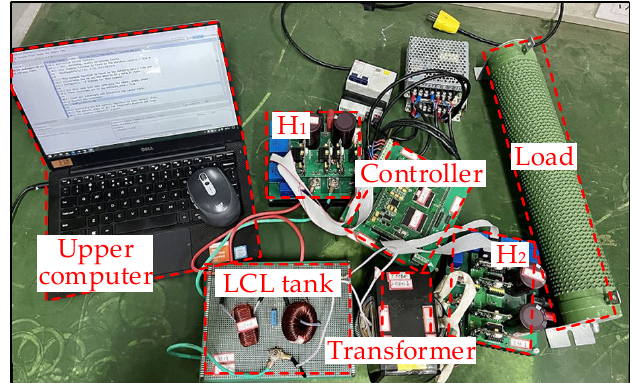
Figure 11. Photo of the experimental platform. Table 2. Main experimental parameters.